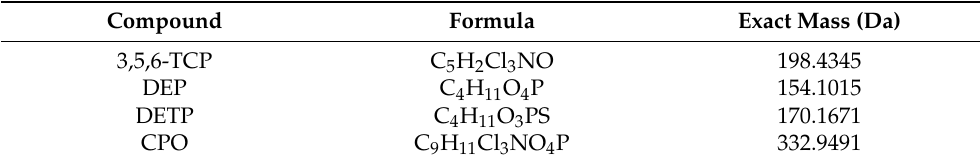
Table 2. List of reported metabolites of chlorpyrifos in references, their formula, and calculated exact